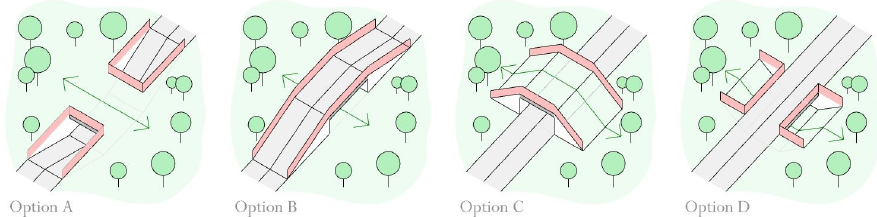
Figure 1. Fauna corridor options diagram. Own source.